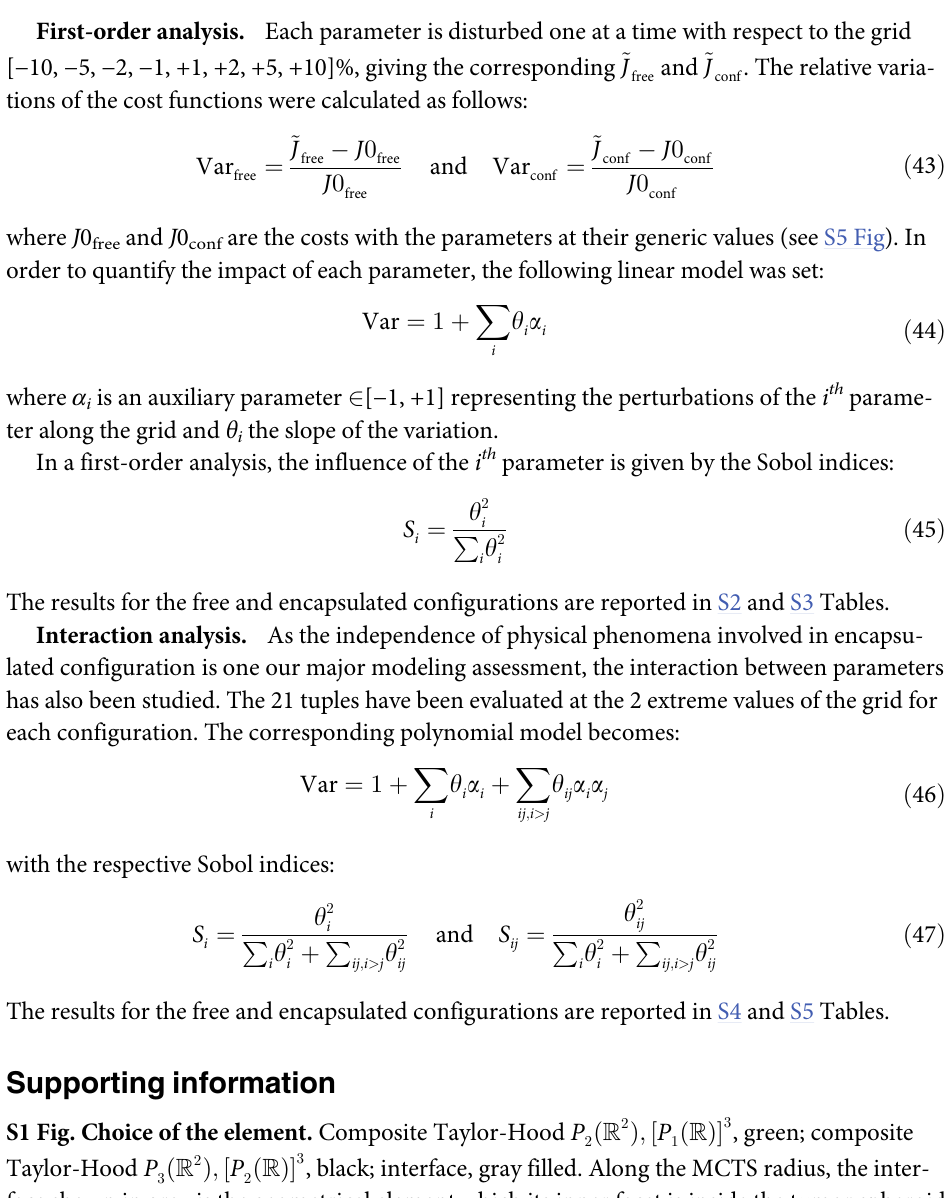
S1 Fig. Choice of the element. Composite Taylor-Hood P ð R 2 Þ ; ½ P ð R Þ� 3 , green; composite 2 1 Taylor-Hood P ð R 2 Þ ; ½ P ð R Þ� 3 , black; interface, gray filled. Along the MCTS radius, the inter- 3 2 face shown in gray is the geometrical element which its inner facet is inside the tumor spheroid subdomain and its outer facet in contact with the alginate subdomain. The linear approxima- tion P ð R Þ of the pressure difference between l and t phases at the capsule interface is poor 1 (Left, Day 1) and provoke numerical infiltration of tumor cells into the alginate capsule (Right, Day 3). The quadratic approximation P ð R Þ at the capsule interface does not provoke numeri- 2 cal infiltration. S2 Fig. Sensitivity of the solution related to mesh refinement. The numerical oxygen mass fraction, o � nl , at the center of the spheroid has been monitored during six days for five different mesh finite element sizes dh . ( dh = 50 μ m, black; dh = 20 μ m, green; dh = 10 μ m, brown; dh = 5 μ m, light blue; dh = 2.5 μ m,